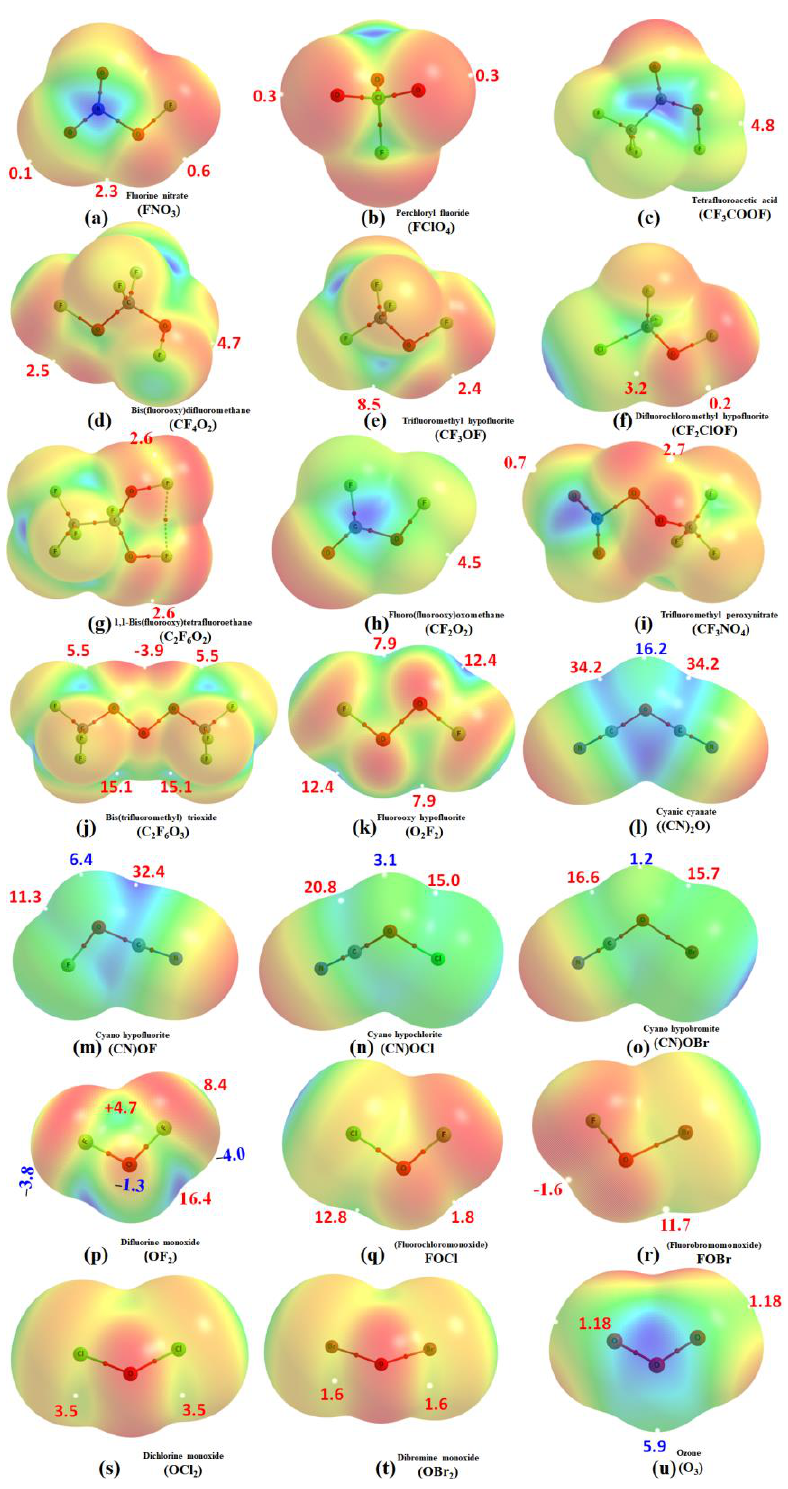
Figure 2. MP2 / aug-cc-pVTZ computed 0.001 a.u. isodensity envelope mapped potential on the molecular electrostatic surfaces of 21 monomers. Selected V S,max (red) and V S,max (blue) values are shown in kcal mol − 1 , marked by tiny white